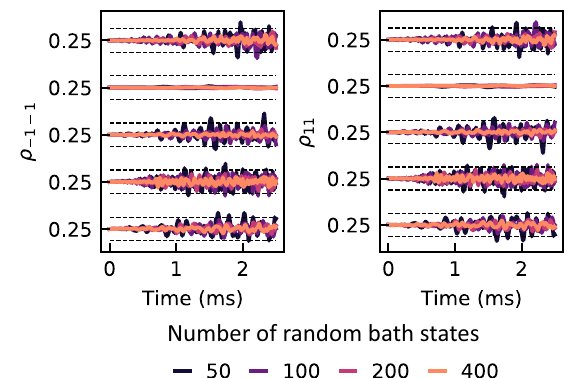
FIG. 11. The convergence of diagonal elements ρ − 1 − 1 and ρ 11 of the density matrix in Hahn-echo measurements of the kh - V C V Si divacancy as a function of the number of random bath states. Calculations are performed for five random nuclear spin configurations at zero magnetic field. Gray dashed lines corre- spond to the ± 10% range. We set ρ 00 = 0.5 for all